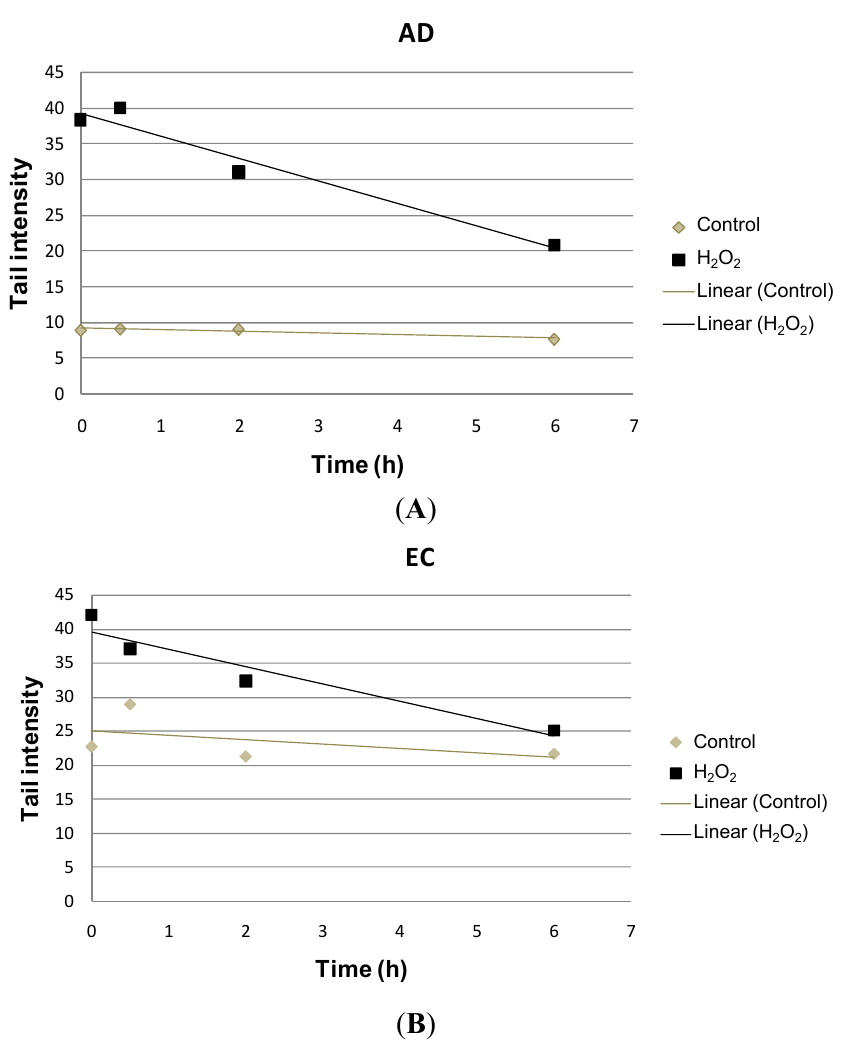
O and the respective EC 2 2 O . 2 2